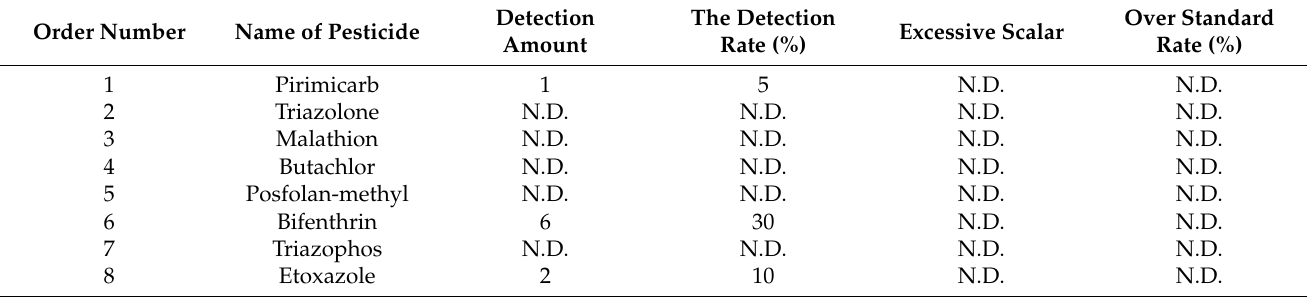
Table 5. Detection results of pesticides residue in potato.